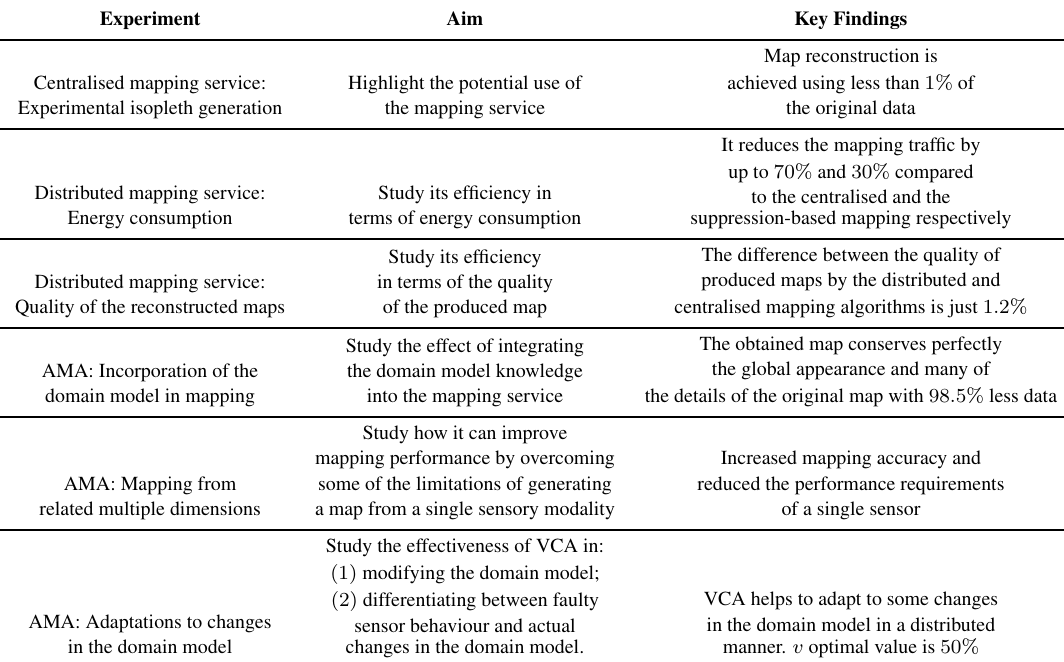
Table 3 summarises all the evaluation experiments and the key obtained results. Table 3. Summary of evaluation experiments and key